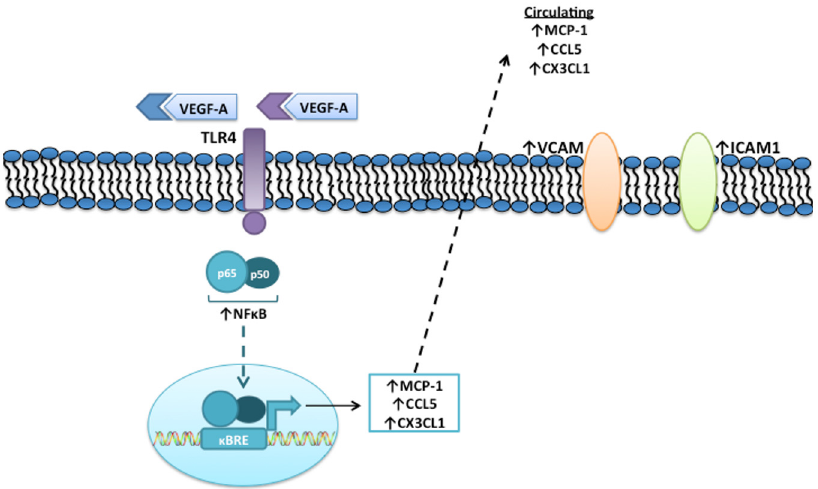
Fig 7. Proposed mechanism for Ranibizumab/Aflibercept induced inflammation. Binding of VEGF-A to Ranibizumab (R) or Aflibercept (A) is essential for Toll-like receptor 4 activation, with downstream activation of intra-cellular NF- κ B, chemokine gene expression and protein secretion and cell adhesion molecule